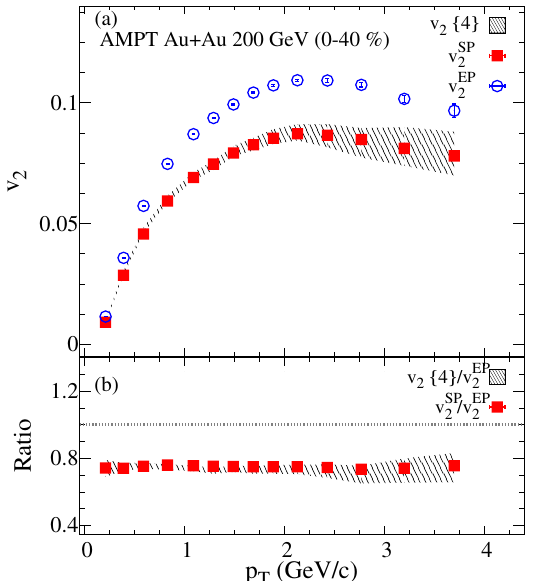
Figure 2. The charged particles p T dependence of v SP elliptic flow (hashed band) panel ( a ). The ratios v SP Au+Au collisions at